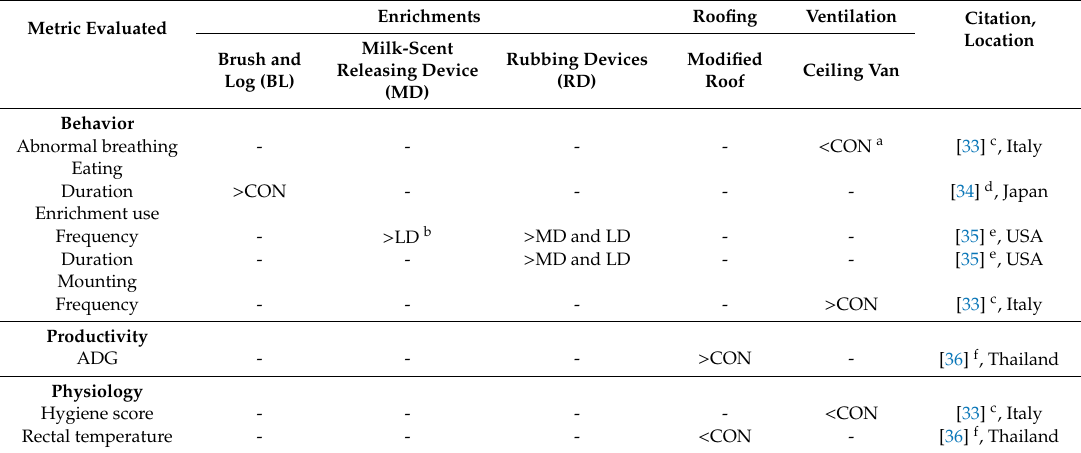
Table 7. Overview of the e ff ect of enrichment devices on beef cattle behavior, productivity and physiology. Enrichments are reported in the same language as they were presented by original study authors. Inclusion of significant results was determined at p < 0.05.